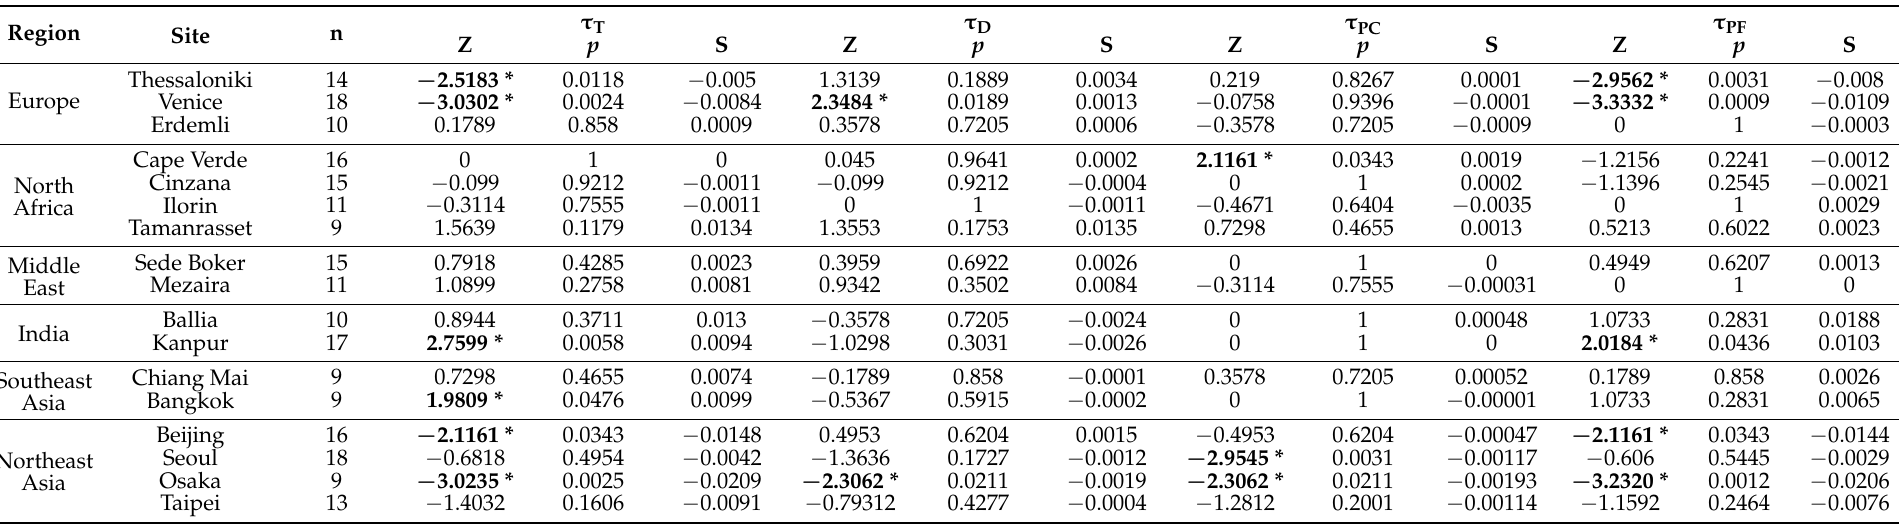
Table 3. MK-test results in terms of number of data points (n), Z-value, p -value, and Sen’s slope (S) of τ (440 nm) according to aerosol type. The Z-value follows